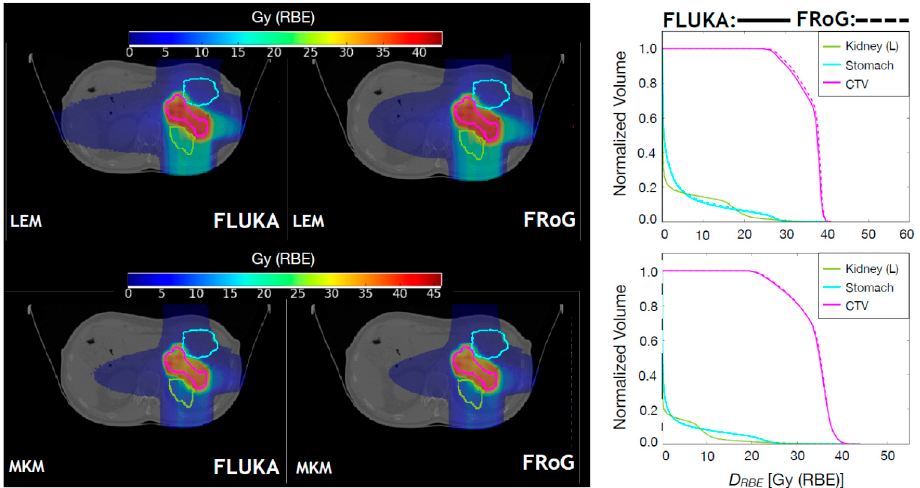
Figure 5. Upper panels: FLUKA and FRoG recalculated LEM-based D RBE distributions for a 12 C ion pancreatic patient case are displayed in the left and middle panel, respectively, together with the contours of three representative regions of interest: CTV, left kidney and stomach. The LEM-based D RBE VH for the ROIs are shown in the right panel. Lower panels: FLUKA and FRoG recalculated MKM-based D RBE distributions for a 12 C ion pancreatic patient case are displayed in the left and middle panel, respectively, together with the contours of three representative regions of interest: CTV, left kidney, and stomach. The MKM-based D RBE VH for the ROIs are shown in the right panel. The average calculation time including absorbed dose, LEM and MKM D RBE for the five H&N cases was about 388 s ± 91 s, ranging from 4 min and 11 s (PTV of 25 cm 3 , 2 beams) to 11 min and 30